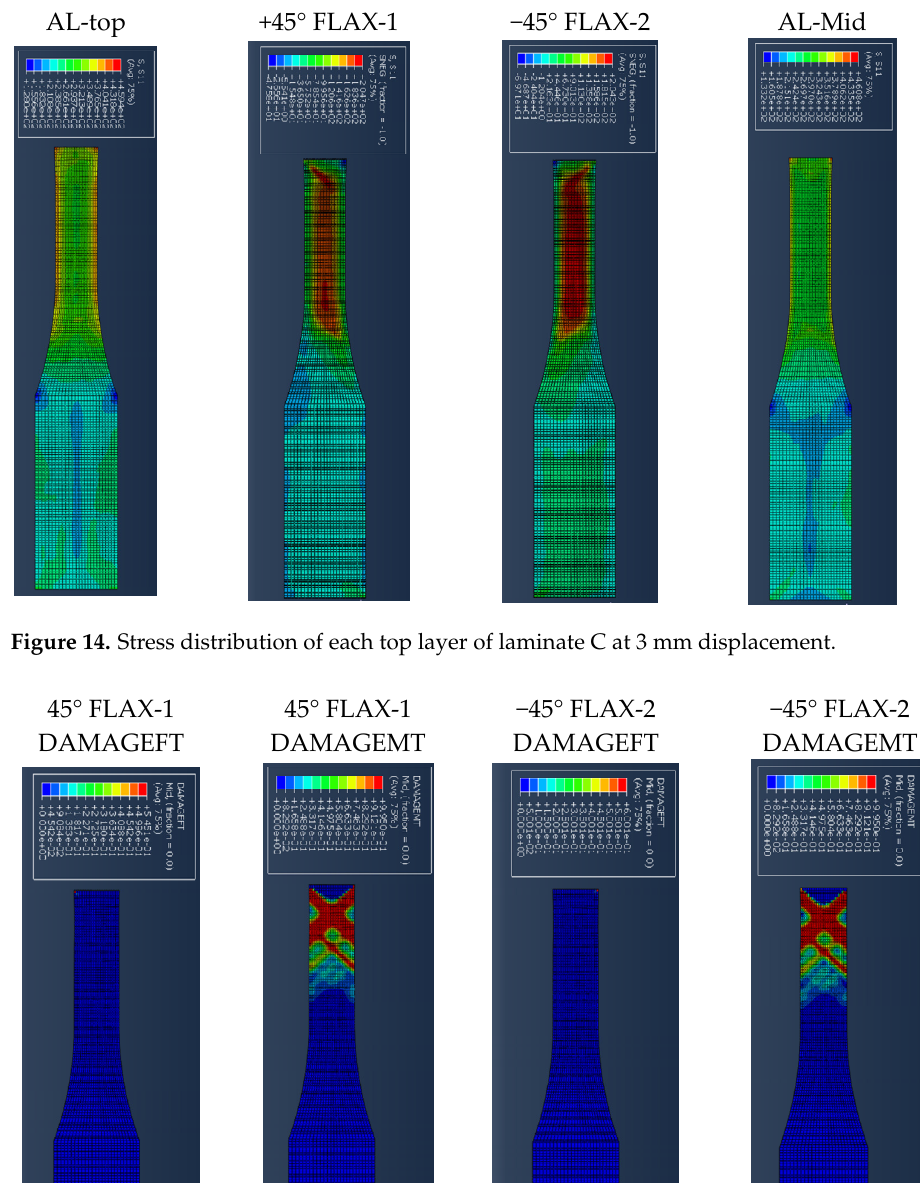
( f ) Figure 13. Delamination of each layer of laminate B after failure; ( a ) 1st interface; ( b ) 2nd interface; ( c ) 3rd interface; ( d ) 4th interface; ( e ) 5th interface; ( f ) 6th interface. The stress distribution of laminate C follows the fibre orientation of the composite layer. Figure 14 shows the displacement at 3 mm, where the stress concentration of the 45° flax layer and the − 45° flax layer is aligned to the fibre direction. Figure 14 shows that the stresses at the aluminium layers are concentrated around the edges. It is worth ob- serving that, when the angle of the principal loading direction is more than 45 degrees compared to the fibre orientation, the metal layers are dominating the load carrying for the whole FML, which can be also verified from Figure 14, with the stresses developed on the Al layers being around 460 MPa, as opposed to circa 205 MPa for the composite layers. The results presented here show that the aluminium layers carry almost double the mag- nitude of stress under tensile loading compared with the composite layers. Figure 15 shows the different damage modes developed on the flax layers of the NFML. It is evident that the matrix cracking is the first model to be observed and is extended along the ±45° direction, as expected. Unlike laminate B, the delamination of laminate C does not have sequences. It rapidly grows on the edge of the specimen. Figure 16 shows that the delamination occurs at the